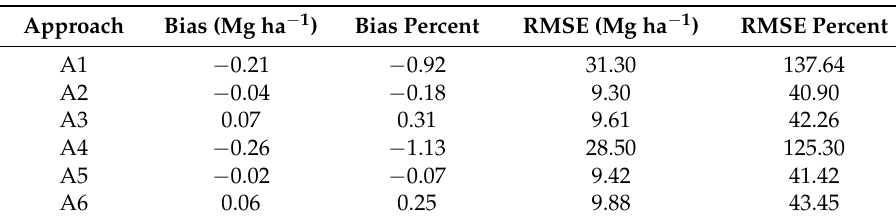
Table 3. Bias, bias percent, RMSE, and RMSE percent obtained from leave-one-out cross validation in estimating change in aboveground biomass per hectare using different